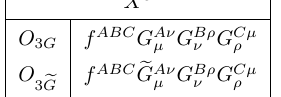
Table 11 . LEFT bosonic operators.